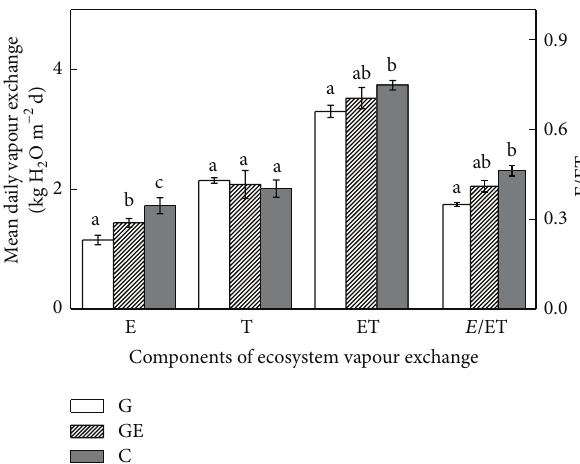
Figure 4: Compositions of mean daily ecosystem vapor consump- tion (E, T, ET, and E/ET) for different steppe grassland uses. The values represent the daily mean values (means ± 1SE) in the peak growing period. Different letters in each bar group indicate significant difference ( 𝑃 < 0.05 ). G, grazing; GE, grazing excluded; C,